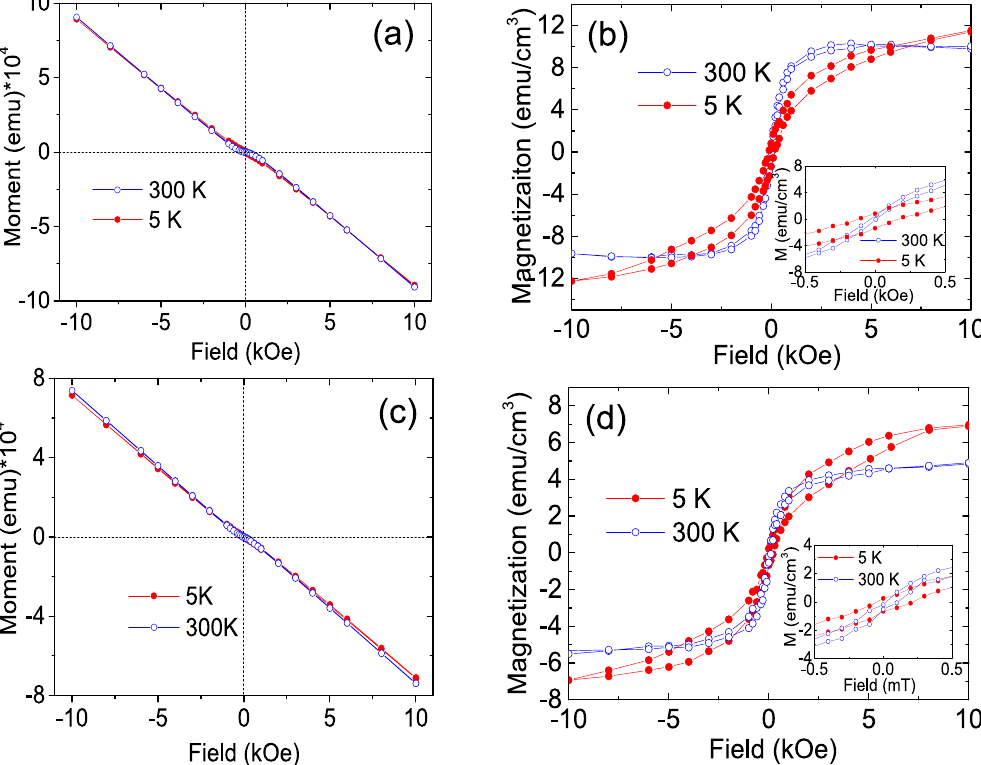
Figure 3. M-H loops for Cu-ZnO films. ( a ) Original curves without the subtraction of substrate signal for PO 2 = 10 − 3 torr sample. ( b ) M-H curve after the substraction of substrate signal of ( a ). ( c ) Original curves without the subtraction of substrate signal for PO 2 = 10 − 5 torr sample. ( d ) M-H curve after the subtraction of substrate signal of ( c